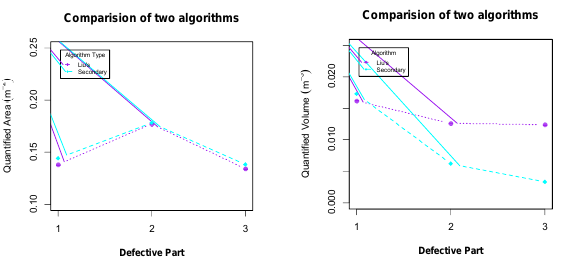
Figure 9. Comparison of two different data processing algorithms